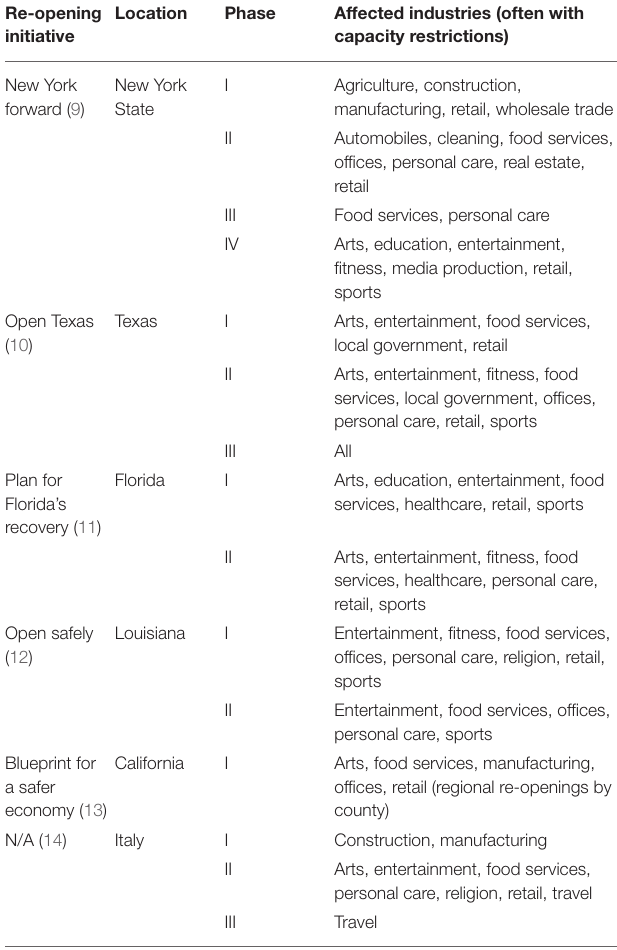
TABLE 1 | Industries affected in various phases of re-opening initiatives. Re-opening